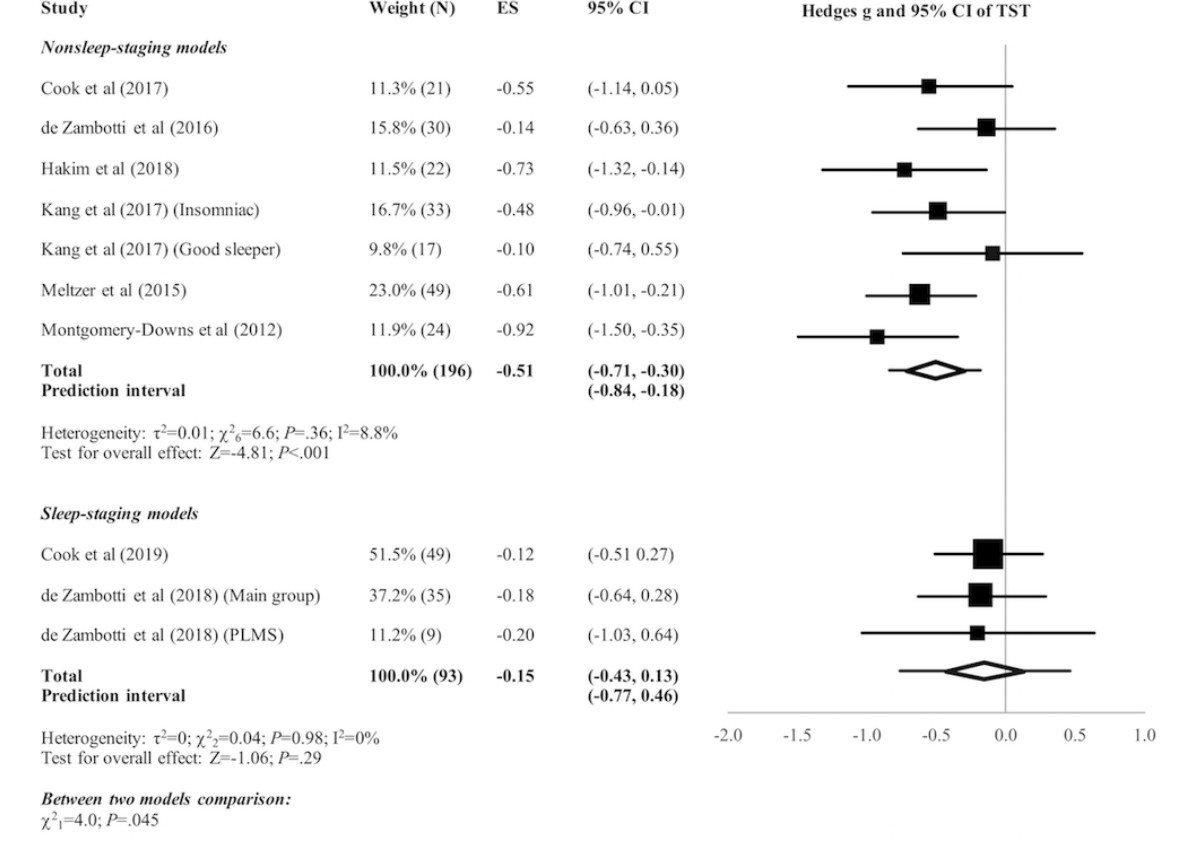
Figure 4. Forest plot of the standardized mean difference (Hedges g) between Fitbit and polysomnography for the variable of total sleep time (TST). Results are shown as effect size (ES) and 95% CI. The difference in symbol size indicates the difference in weight of the respective studies. The diamond symbol shows the 95% CI of the overall effect and the tails show the 95% prediction interval of the overall effect. PLMS: periodic limb movement in sleep.